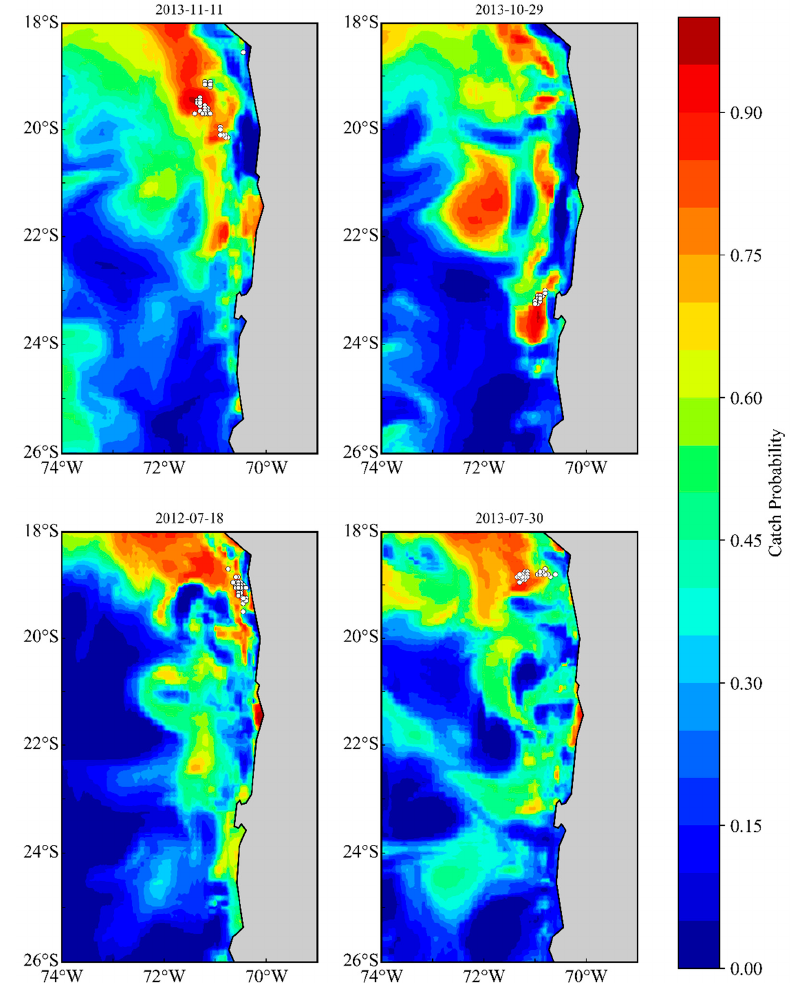
Figure 5. Maps of catch probabilities predicted by the neural network model applied to the fishery of anchovy ( E. ringens ) in Northern Chile, for the four days with the greatest catch in the 2003–2020 period (the 36 days with the greatest catch were ranked, and the first four were displayed). White circles indicate where E. ringens was captured.